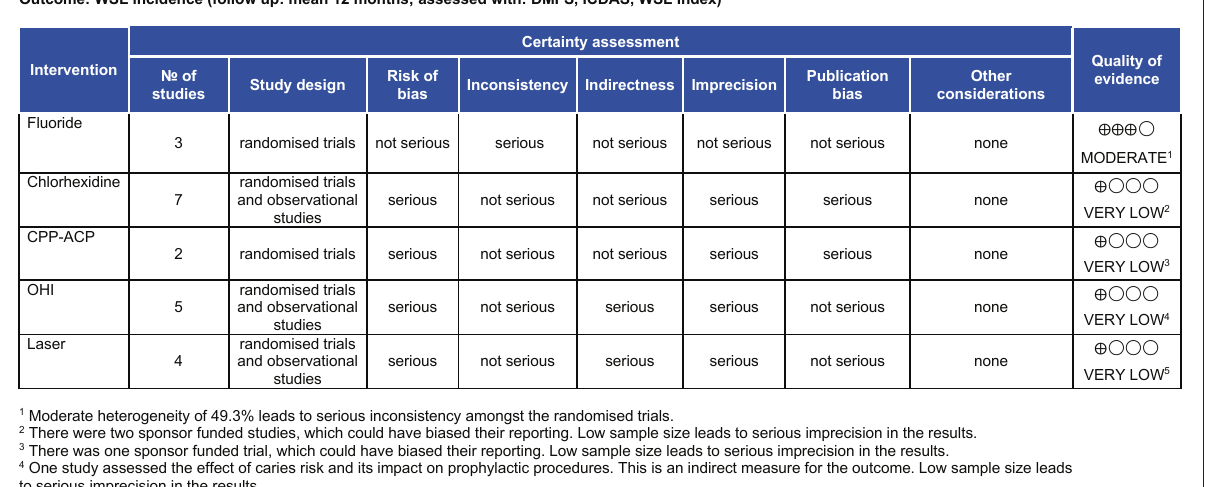
Preventing the development of carious lesions during orthodontic treatment: An evidence-based guideline for clinicians Outcome: WSL incidence (follow up: mean 12 months; assessed with: DMFS, ICDAS, WSL Index)